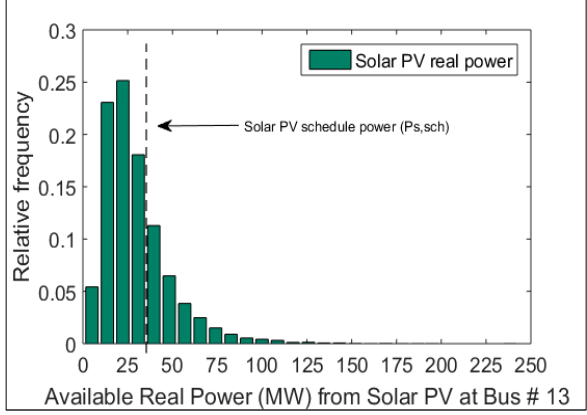
Figure 5. Distribution of SPV real power at bus #13.